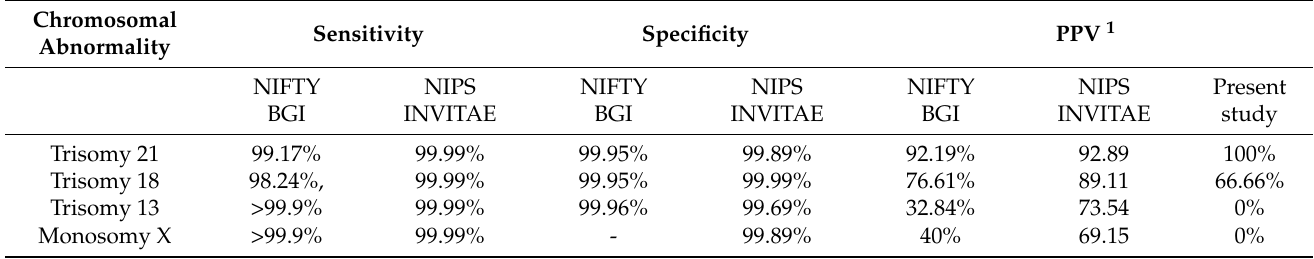
Table 6. Comparison of specificity, sensitivity and ppv scores for aneuploidies between NIFTY and NIPS